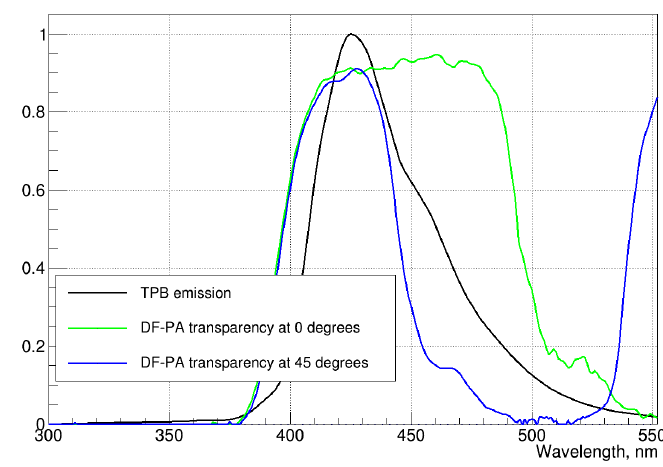
Figure 3. TPB emission spectrum [16] (in a.u.) and the dichroic mirror transparency overlap for incidence angle within the range of 0 to 45